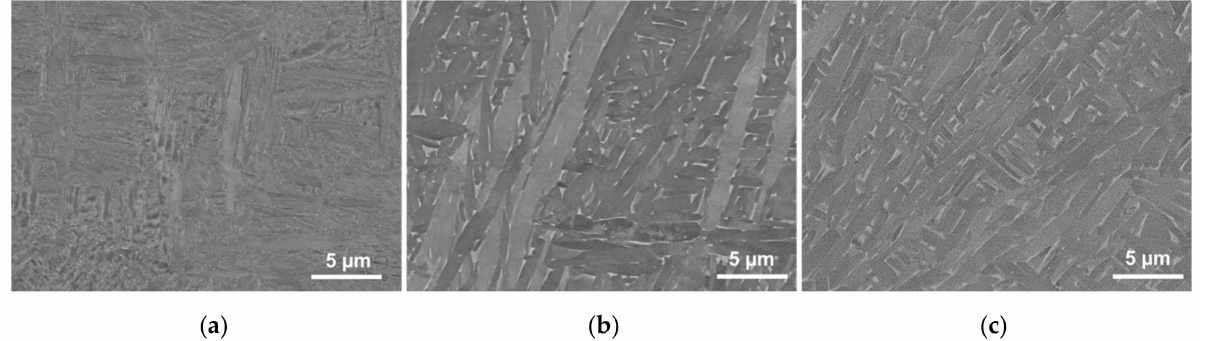
Figure 3. SEM images of the microstructure after heat treatment: ( a ) SR and ( b ) FA, and ( c ) after HP.